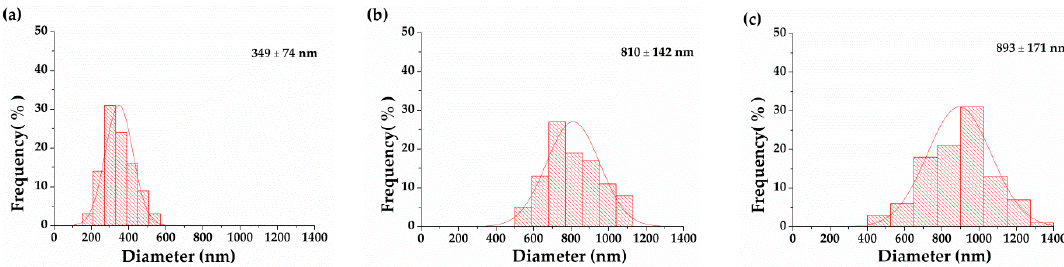
Figure 5. Diameter distribution of PVA/EGO nanofibrous membranes made of a specified spinning voltage of 15 kV. The PVA/EGO ratios are ( a ) 95/5, ( b ) 90/10, and ( c ) 85/15.